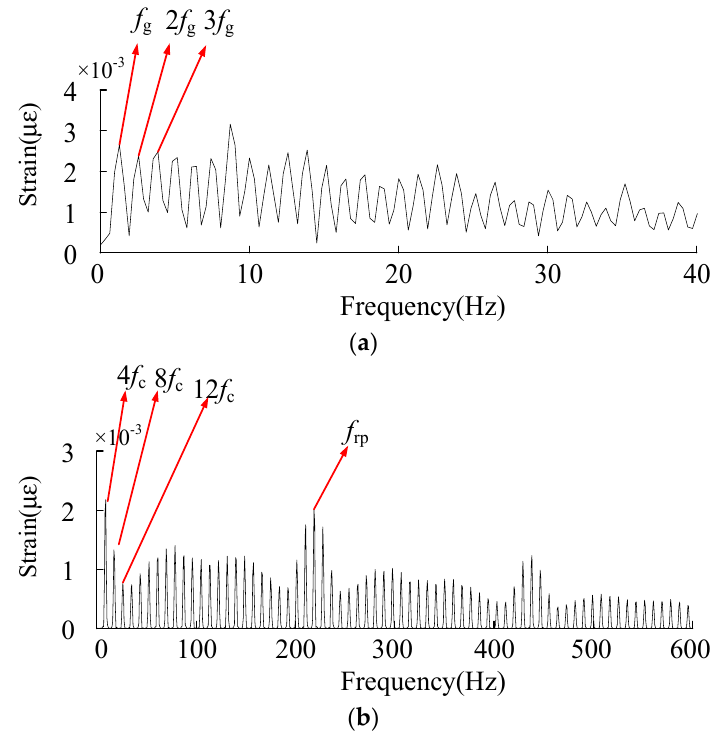
Figure 25. ( a ) Sun gear tooth crack fault signal. ( b ) Inner ring crack fault signal. According to the sun gear tooth crack fault cycle, T g solved above is the corresponding fault frequency f g . In the signal envelope diagram of the sun gear tooth crack, the fault frequency, and its frequency doubling are obvious. After processing the fault signal of the inner gear ring crack, the main components are four times the planetary frame rotation frequency and frequency doubling, and meshing frequency and no obvious fault components